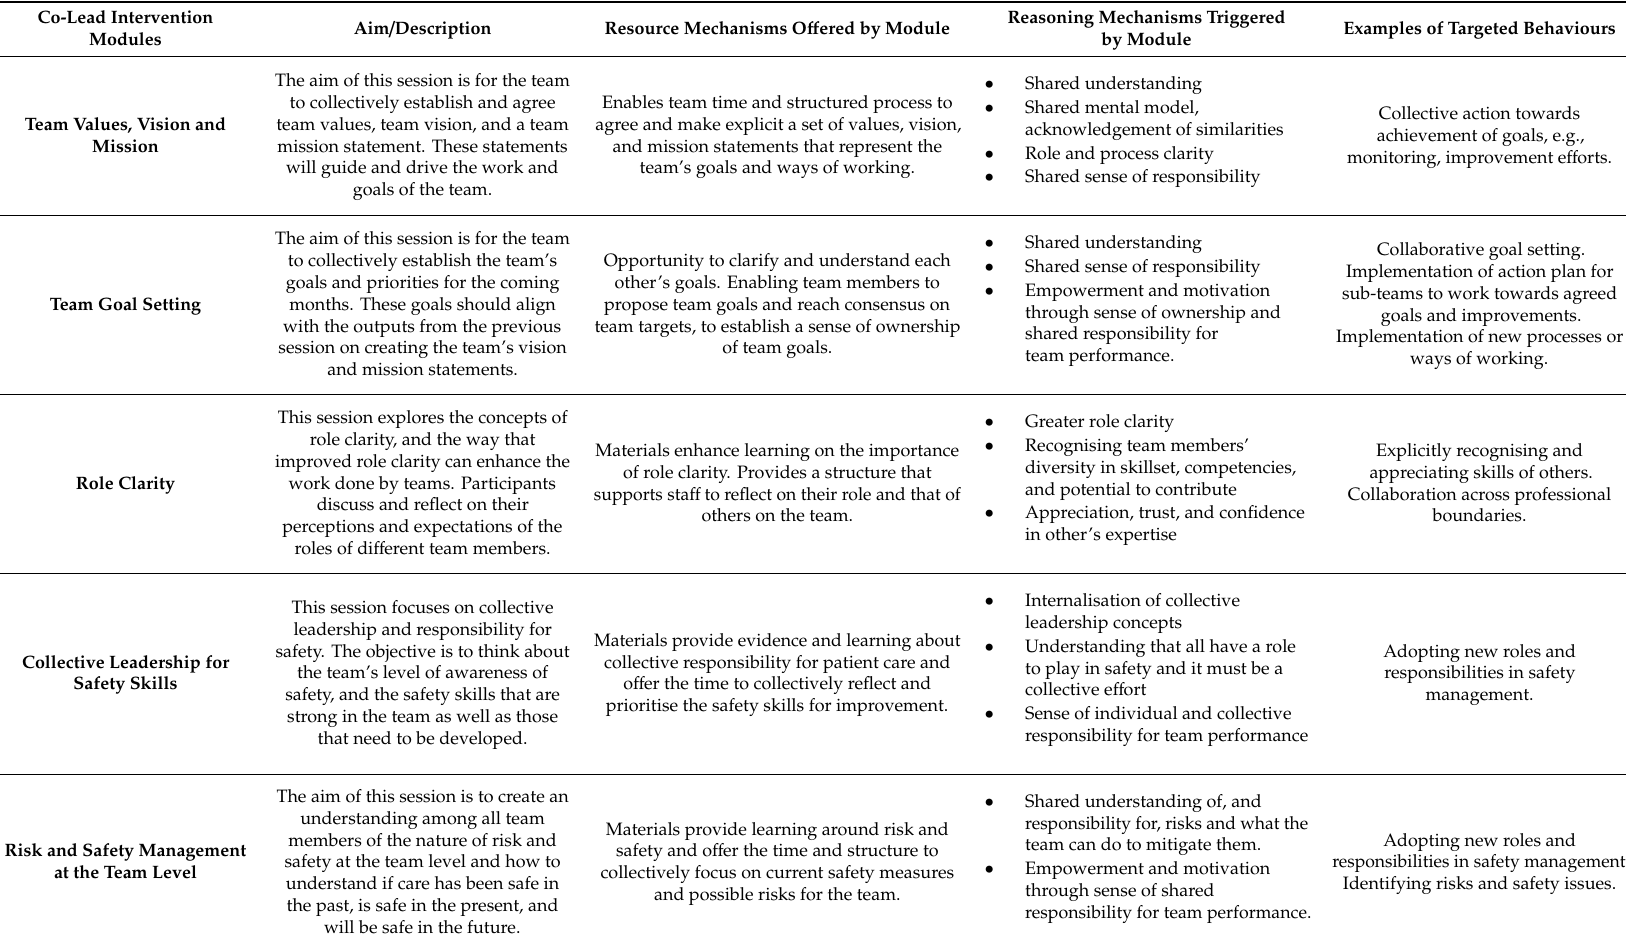
Table A1. Co-Lead intervention modules: summary, mechanisms of action and target behavioural